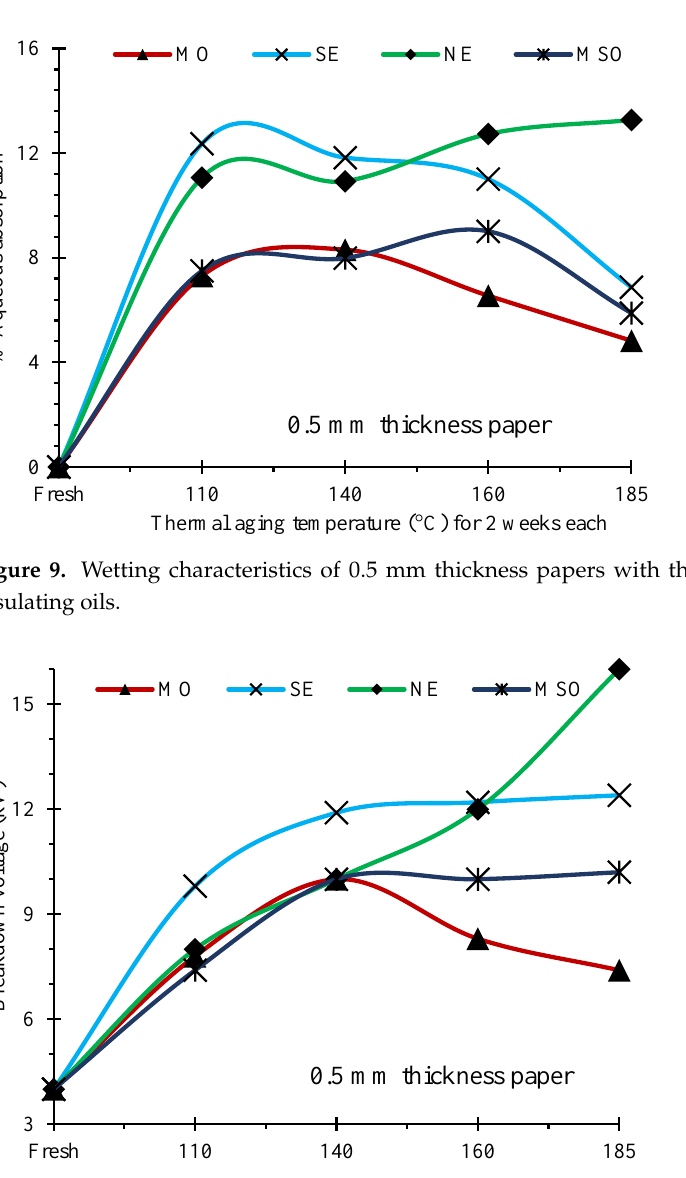
Figure 8. Change in paper BDV with the diffusion of various insulating oils for 0.2 mm thickness papers with thermal stresses.